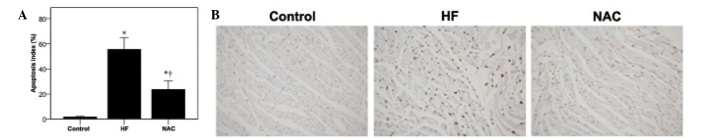
Effects of NAC on myocardial cell apoptosis in heart failure. (A) The apoptotic index was determined using the TUNEL assay. Pair-wise multiple comparisons between groups were determined using Bonferroni’s test with α=0.017 adjustment. *P<0.05 indicates a statistically significant difference between the indicated group and the control group; †P<0.05 indicates a statistically significant difference between the indicated group and the HF group. (B) Representative images of the TUNEL analysis from each group are demonstrated (magnification, ×400). NAC, N-acetylcysteine; HF group, untreated heart failure group; TUNEL, Terminal deoxynucleotidyl transferase-mediated dUTP nick end labeling.